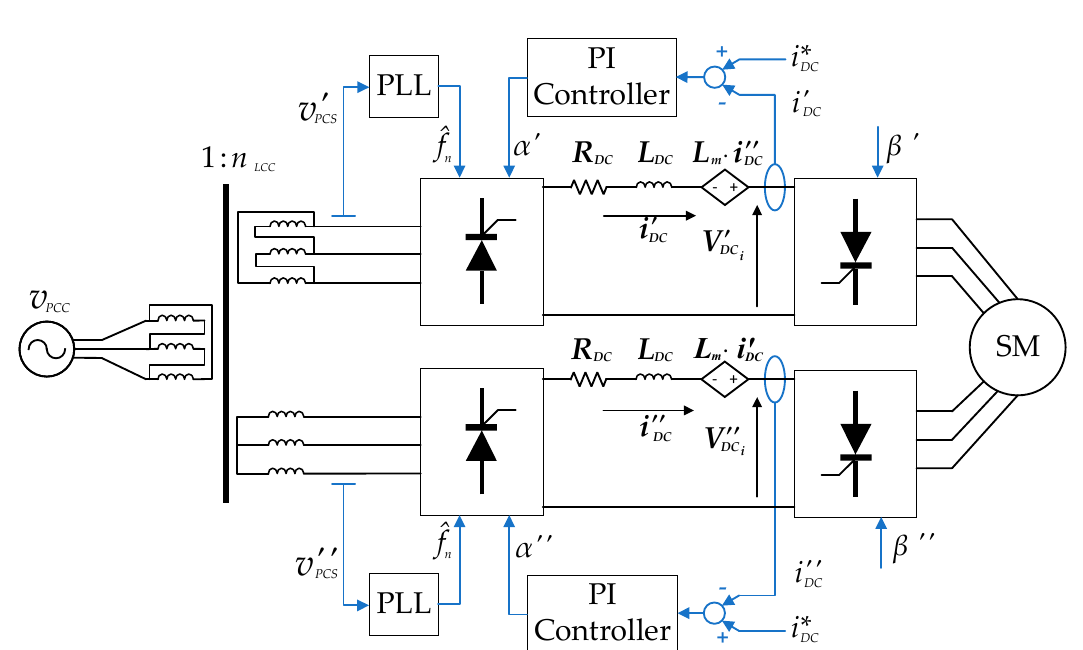
Figure 4. Thyristor Variable Frequency Drive (TVFD).